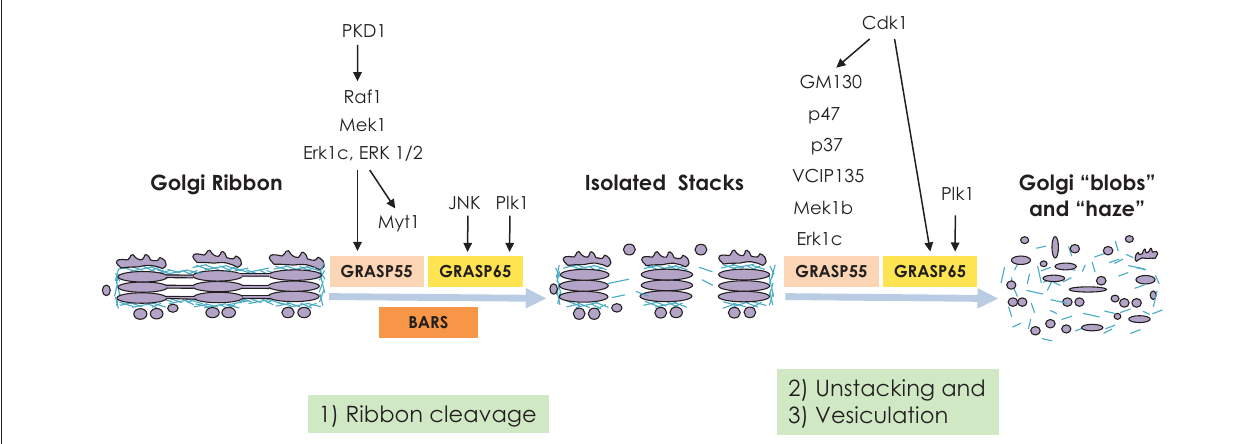
FIGURE 1 | Schematic representation of mitotic partitioning of the Golgi ribbon. This first step of mitotic Golgi fragmentation (i.e., ribbon unlinking) controls G2/M transition and requires the activities of BARS, GRASP55, and GRASP65. These processes also require the activities of several MAP kinase components, as indicated. At the onset of mitosis, these isolated stacks undergo further disassembly in the sequential steps of unstacking and vesiculation. These lead to the formation of the so-called “Golgi haze” during metaphase, where the Golgi membranes are completely fragmented. These processes require the activities of the kinases Plk1 and Cdc2, and their targets GRASP55 and GRASP65. Subsequent events result in dephosphorylation of the kinases that took part in the initial fragmentation, which leads to reassembly of the Golgi ribbon in the daughter cells.